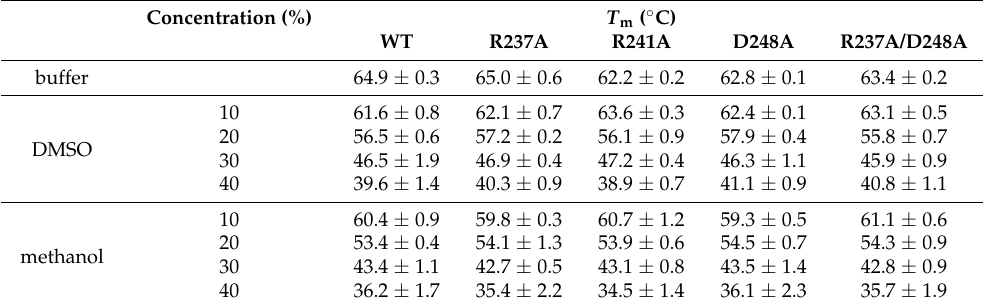
Figure 6. Organic solvent stability of WT and mutant PML enzymes. Stability of PML enzymes in 10–40% DMSO (left panel) and 10–40% methanol (right panel) at 25 ◦ C. Data correspond to the mean ± SD of three experiments. Table 2. Melting temperature of WT and mutant PML enzymes in 0–40% DMSO and